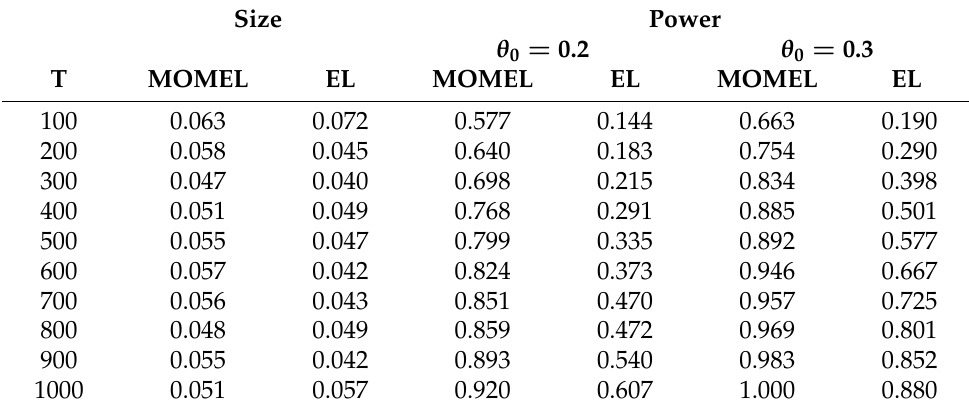
Table 6. Size and power in Example